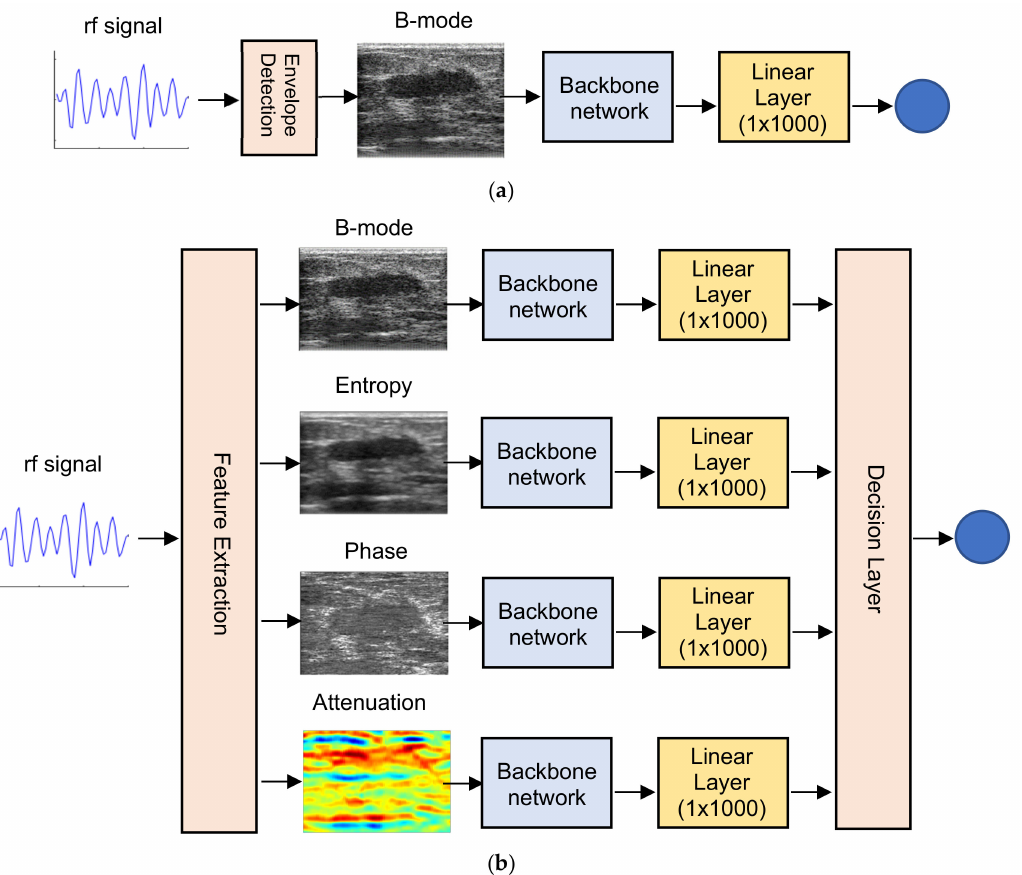
Figure 5. Architectures of CNN-based deep learning networks. ( a ) Traditional classification network with the B-mode image; ( b ) Proposed ensemble network with four parametric